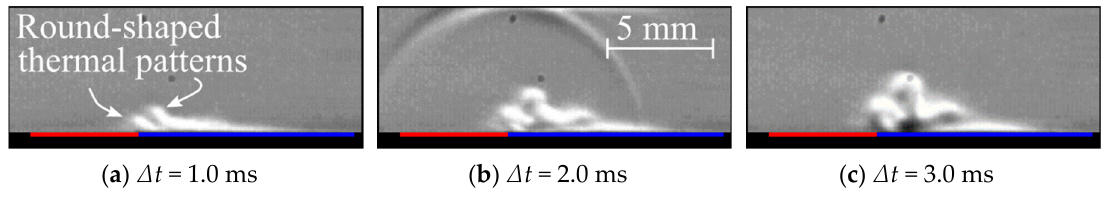
Figure 7. Temporal variation of the hot plume during the first burst event (Case 5, BR = 0.57).